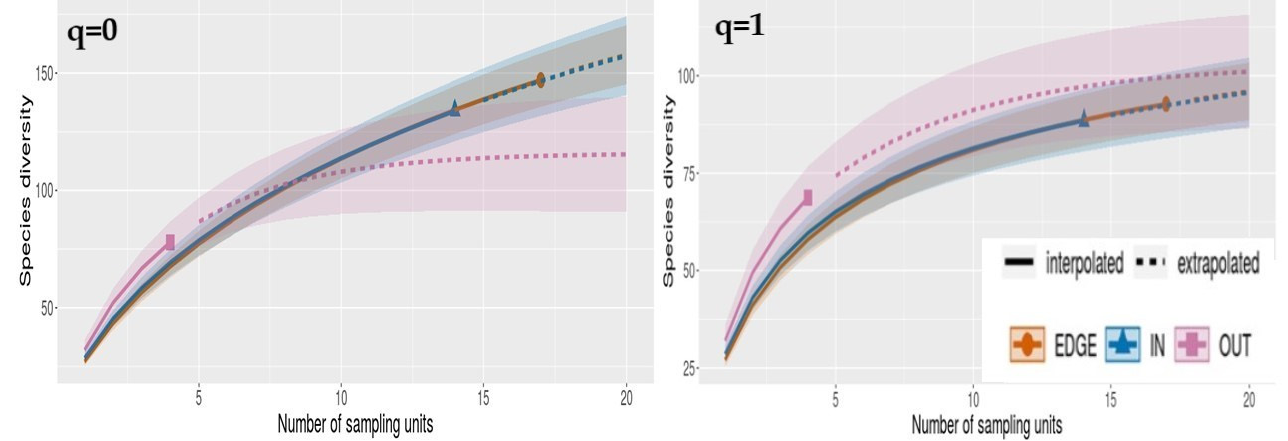
Figure 7. Sample-size-based rarefaction and extrapolation sampling curves within growing location of tree sites showing Hill numbers q = 0 (species richness) and q = 1 (exponential of Shannon entropy index). Color-shaded areas are 95% confidence intervals. Solid symbols represent the total number of study samples.